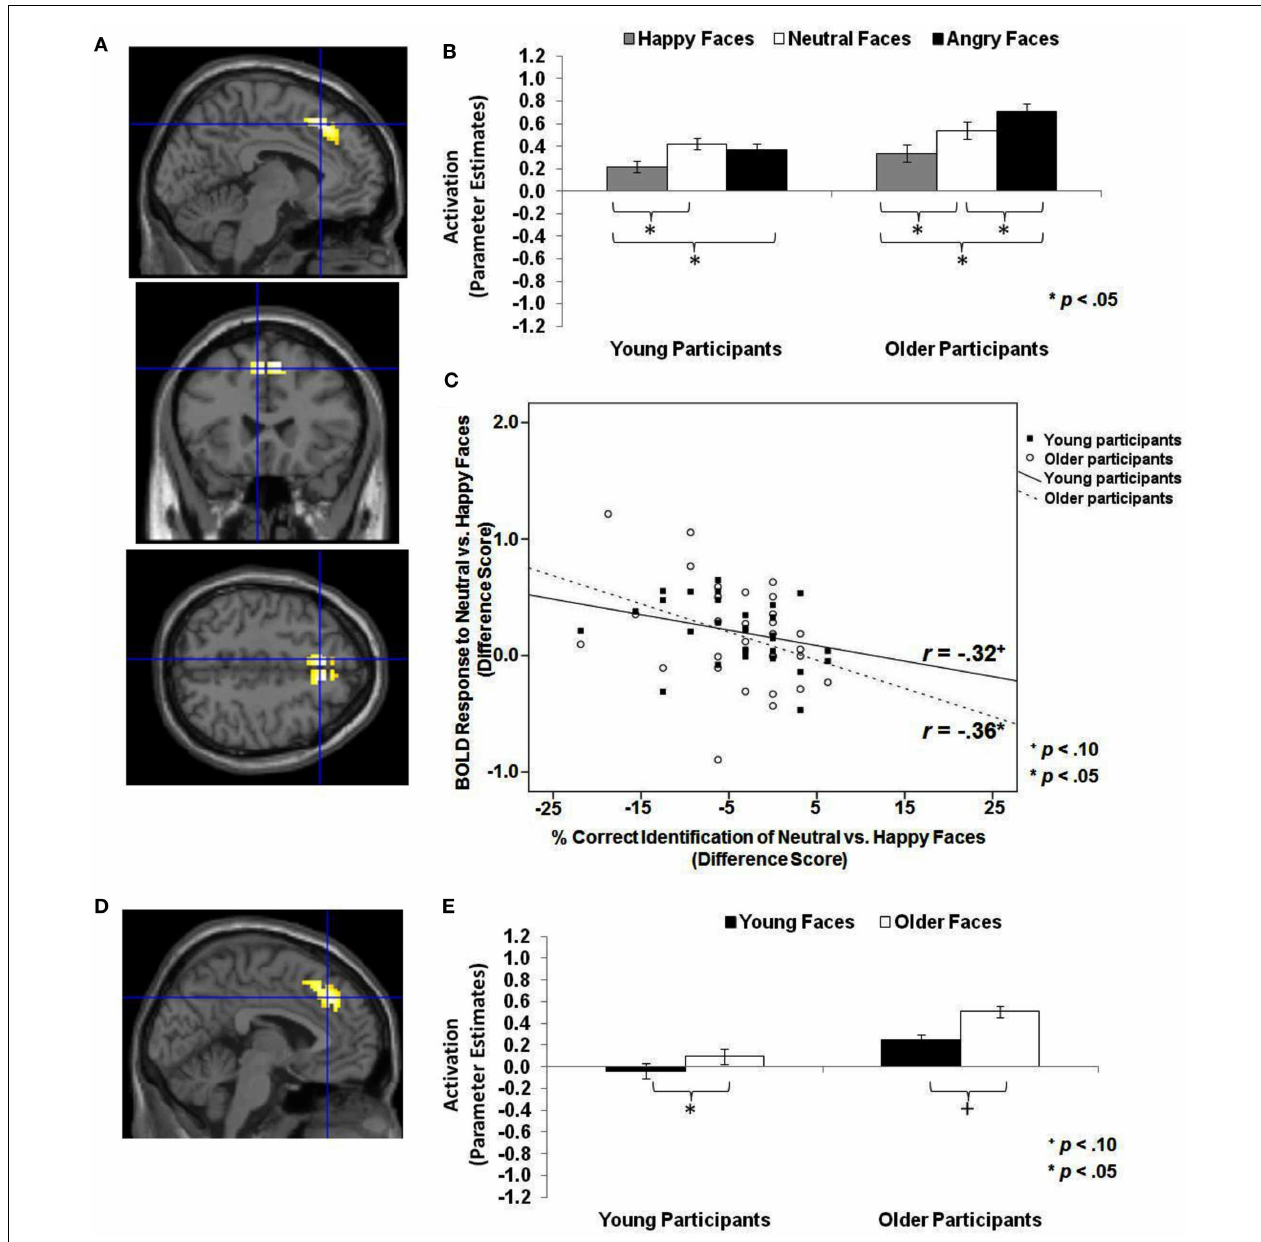
happy faces in relation to the percentage of correctly identified neutral relative to happy faces for young and older participants, respectively. older faces > young faces : (D) Left medial frontal gyrus, anterior cingulate, superior frontal gyrus (BA 8, 32; MNI: x =− 3, y = 33, z = 39; cluster size: 102 voxels; maximum T -value for cluster: 4.94).The region of activation represents the T -map of the contrast; it is displayed on the standard reference brain in SPM.The crosshair indicates the peak voxel (local maximum) within the region of activation. (E) Bar graphs show the mean left dmPFC parameter estimates (beta values) separately for age of face and age of participant (across facial expression); betas for this region of activation identified by the T -contrast older faces > young faces were extracted for each individual from a 5-mm sphere around the local maximum within the region of activation and averaged to produce a single value for each condition of interest,